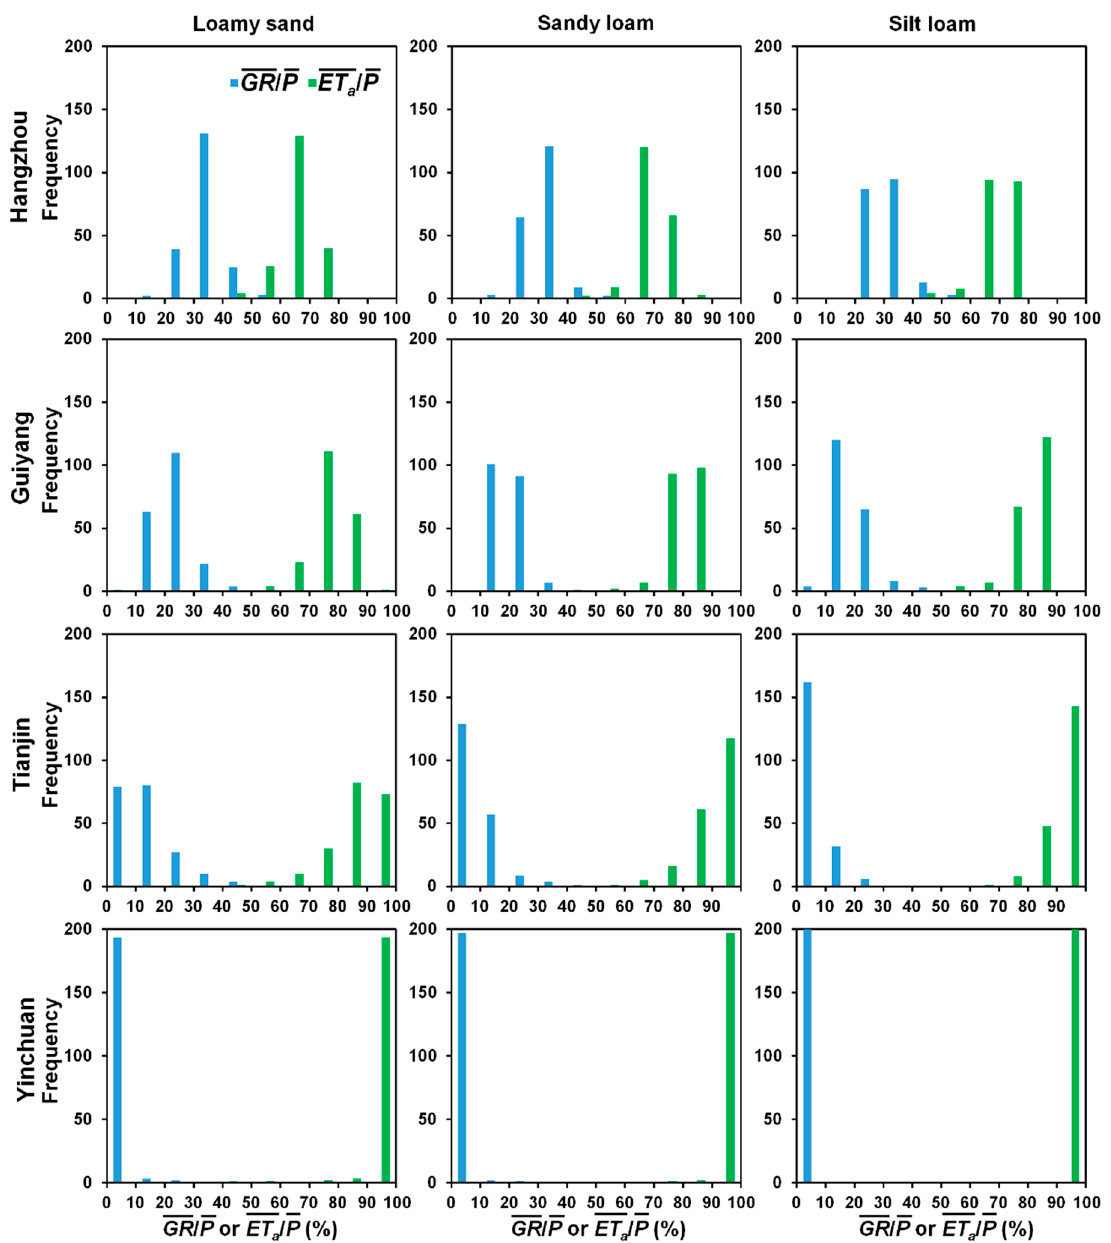
Figure 3. Distributions of simulated mean annual ratios of actual evapotranspiration ( ET a ) and Figure 3 . Distributions of simulated mean annual ratios of actual evapotranspiration ( 𝐸𝑇 (cid:3028) (cid:3364)(cid:3364)(cid:3364)(cid:3364)(cid:3364) ) and groundwater recharge ( GR ) over precipitation ( P groundwater recharge ( 𝐺𝑅(cid:3364)(cid:3364)(cid:3364)(cid:3364) ) over precipitation ( 𝑃(cid:3364) ).